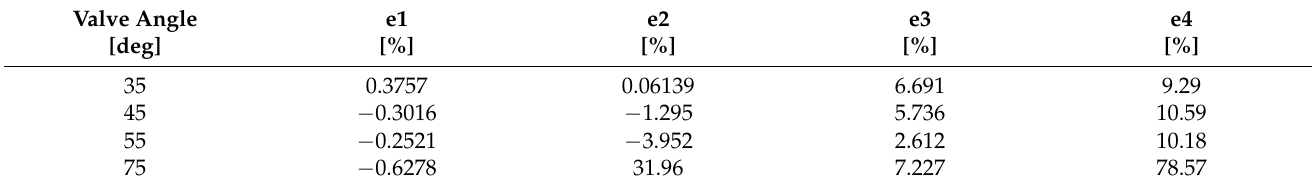
Table 5. Simulation Cases: error